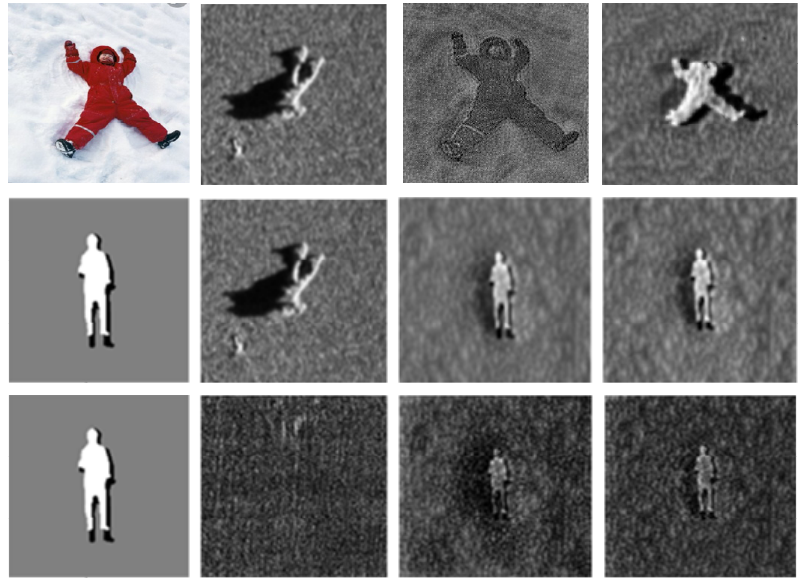
Figure 5. Results of the ablation experiments: the first row is the direct style transfer of the optical image; the second and third rows are the style transfer after optical image processing.